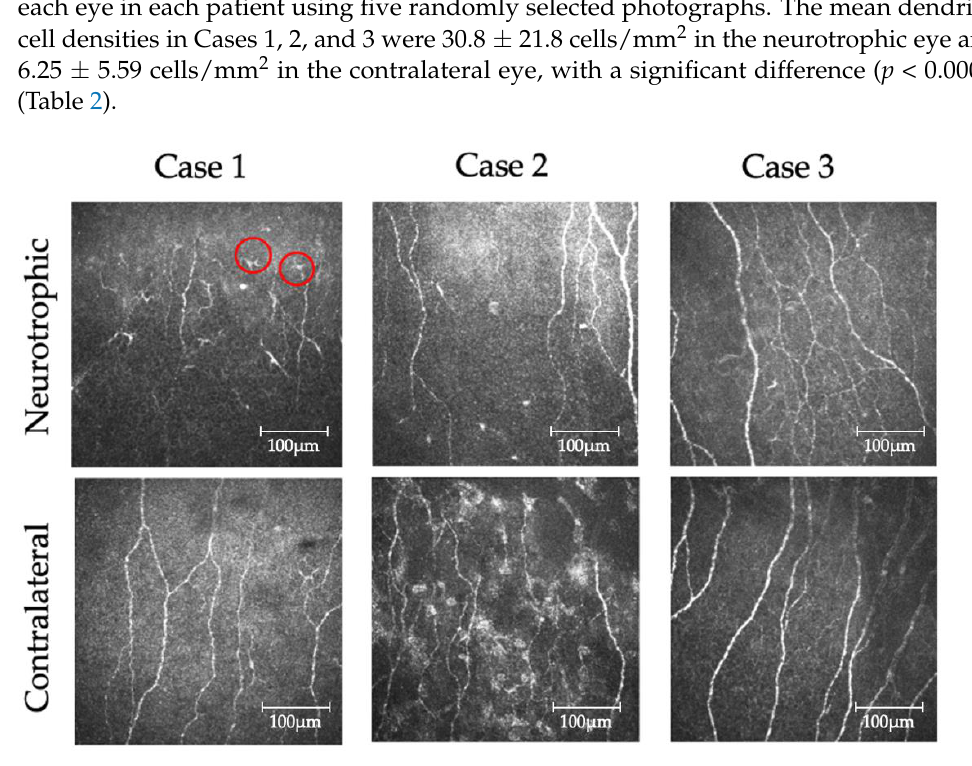
Figure 3. In vitro confocal microscopy observation of dendritic cells. All dendritic cells (red circle) were manually counted. The numbers of dendritic cells were counted from 5 photographs in each patient. The mean number of dendritic cells in the neurotrophic eyes was larger than that in the contralateral eyes.